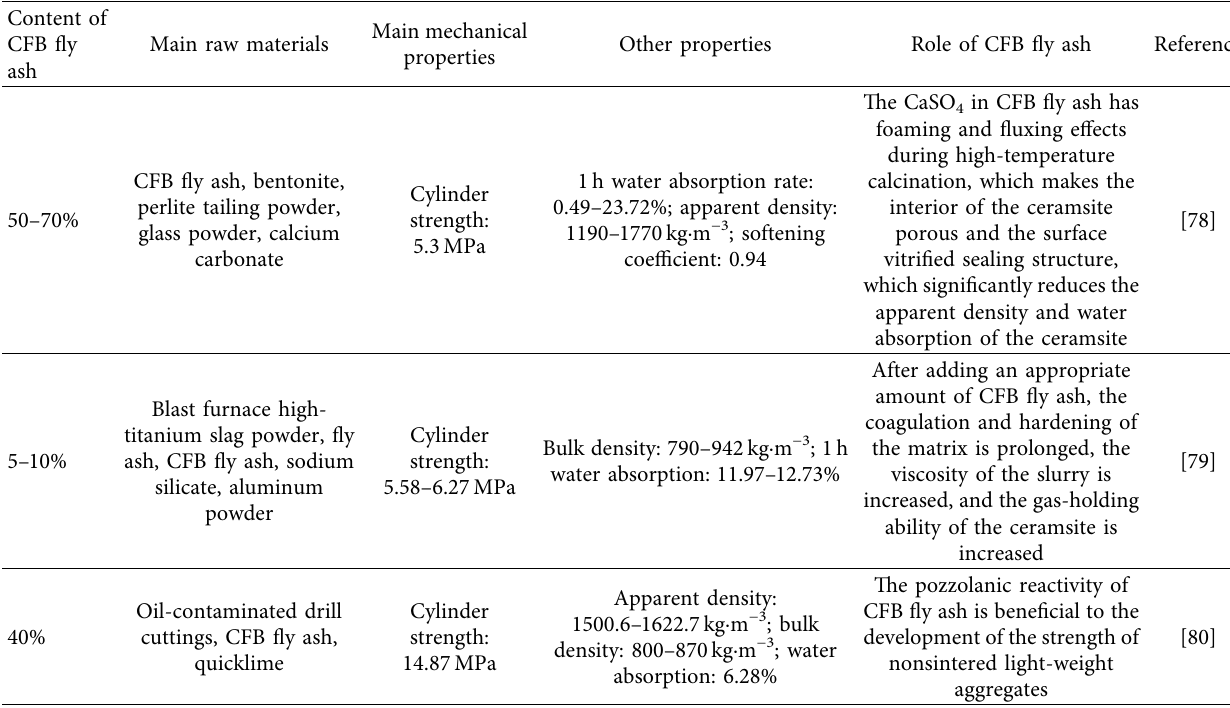
Table 8: Application of CFB fy ash in artifcial